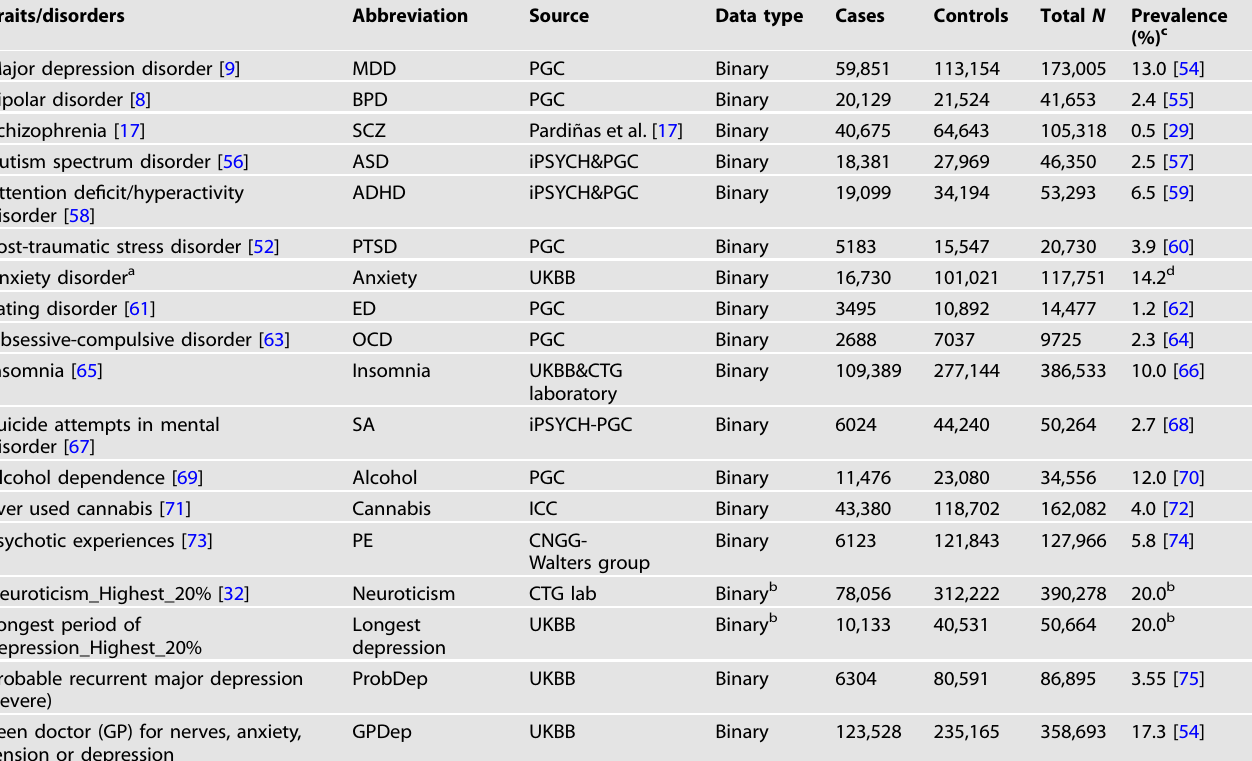
Table 1. Summary of GWAS data of 18 psychiatric traits/disorders included in this